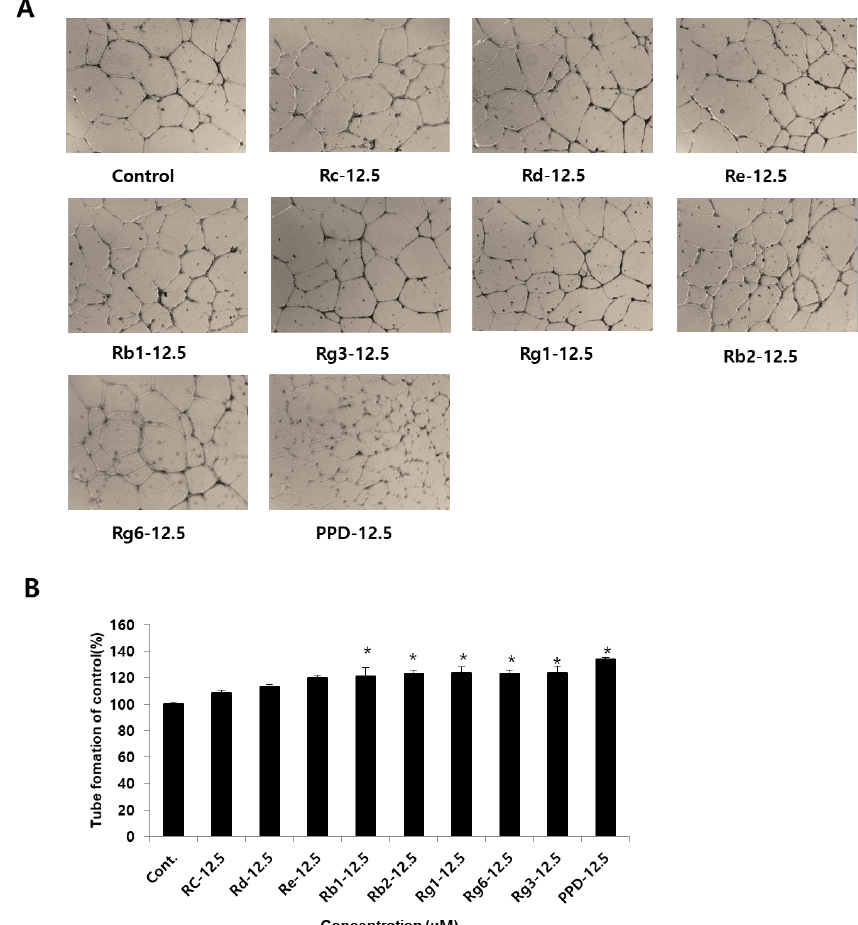
Figure 4. Effects of ginsenosides and PPD on HUVEC tube formation. ( A ) Photographs of tube formation of HUVECs with or without ginsenosides and PPD (12.5 µ M) after 24 h. ( B ) Tube formation effects were quantified using ImageJ software. Data are presented as the mean ± standard deviation (SD) of three independent experiments. * p < 0.05 compared to the control group.